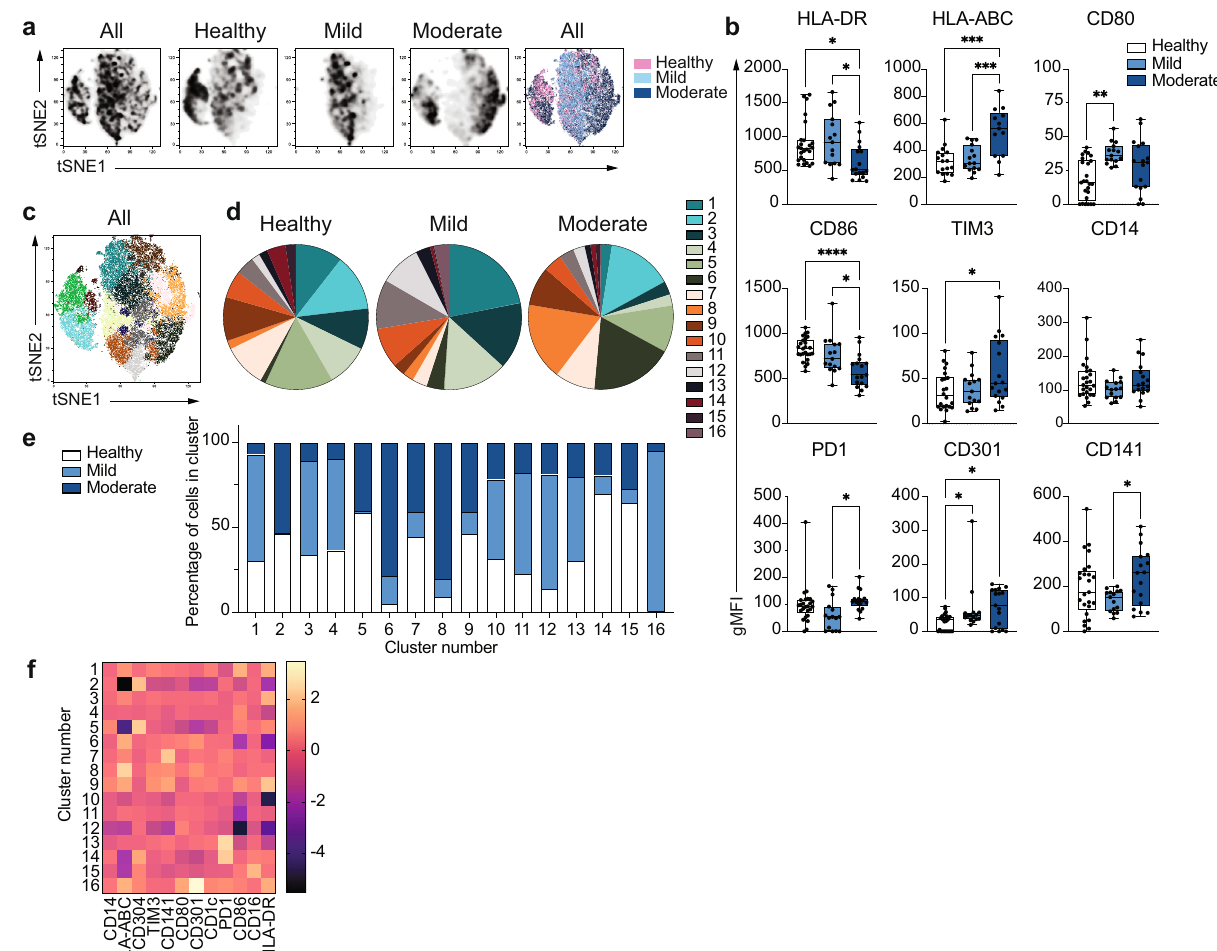
Fig. 1 | Unique phenotype ofCOVID-19 monocytes.a tSNE plots obtainedfrom a concatenated sample consisting of CD14 + classical monocytes from n =15 healthy individuals, n =15 mild and n =15 moderate COVID-19 patients. b Box-and-whisker plotssummarizingthemediangMFIofthereceptorsanalyzed( n =25healthy, n =15 mild and n =17 moderate COVID-19 individuals). c tSNE plots depicting the cell clusters identi fi ed by Phenograph from the concatenated sample in a . d Pie charts